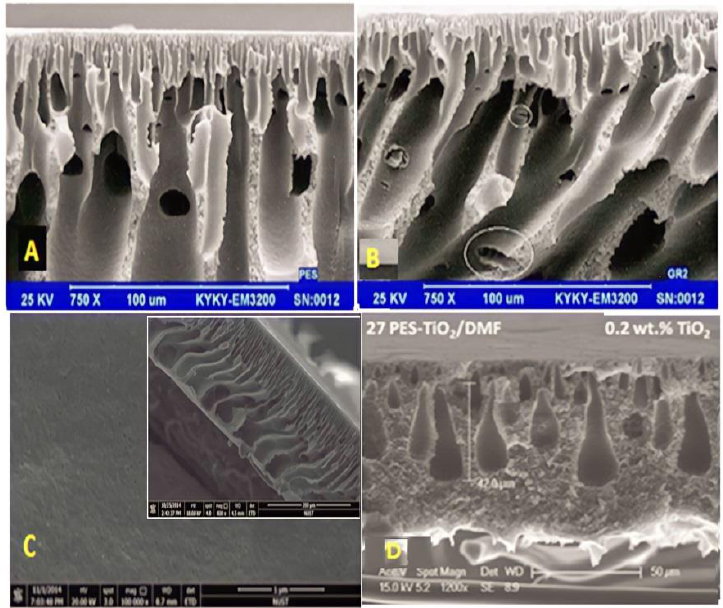
Figure 7. SEM images of the PES membrane with different addition of nanoparticles. ( A ) Pure PES [126], ( B ) 0.5 wt% GO [126], ( C ) 0.75 wt% ZNO [127], and ( D ) 0.2 wt%TiO 2